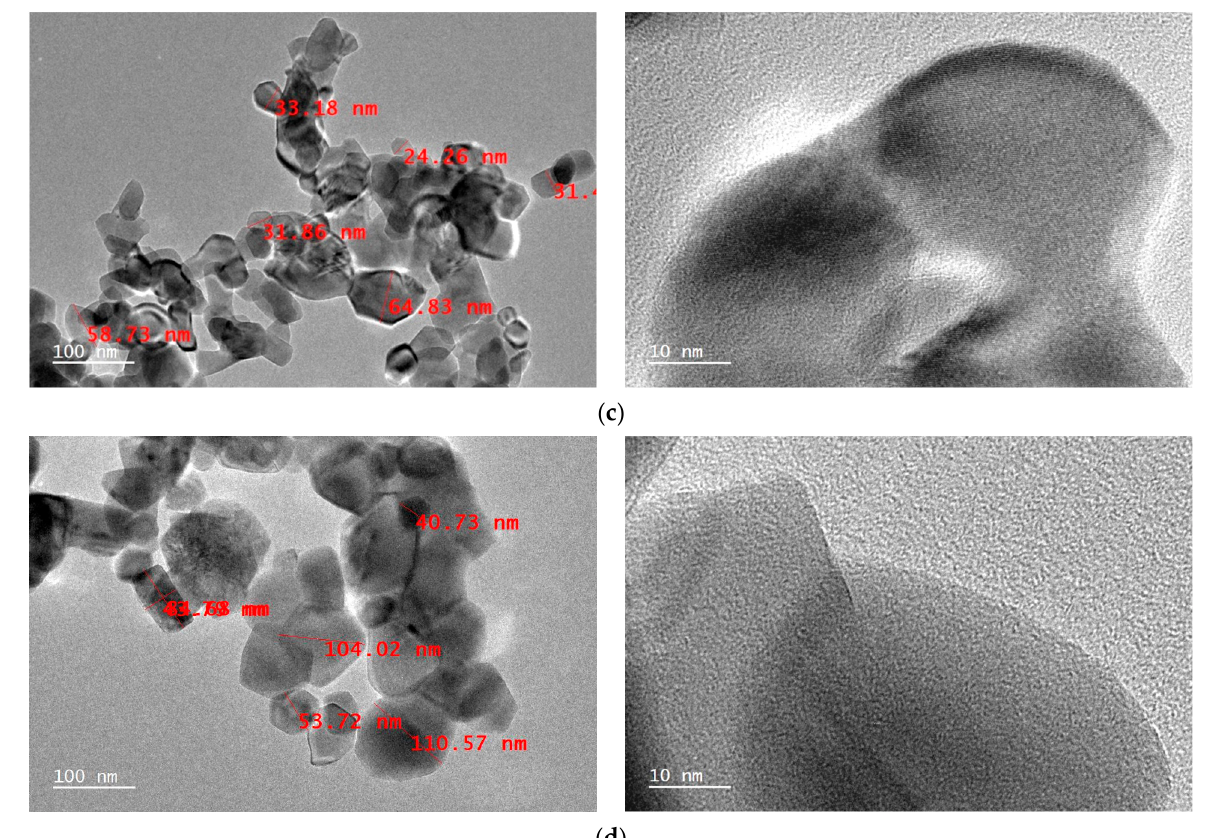
Figure 6. HRTEM observations of NiO NPs heat-treated at ( a ) 300 °C; ( b ) 400 °C; ( c ) 500 °C; ( d ) 600 °C.